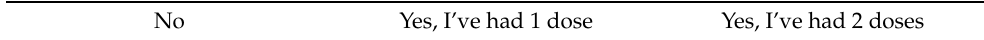
Table A3. Have you been vaccinated for the Coronavirus (COVID-19)? (please select one option only).